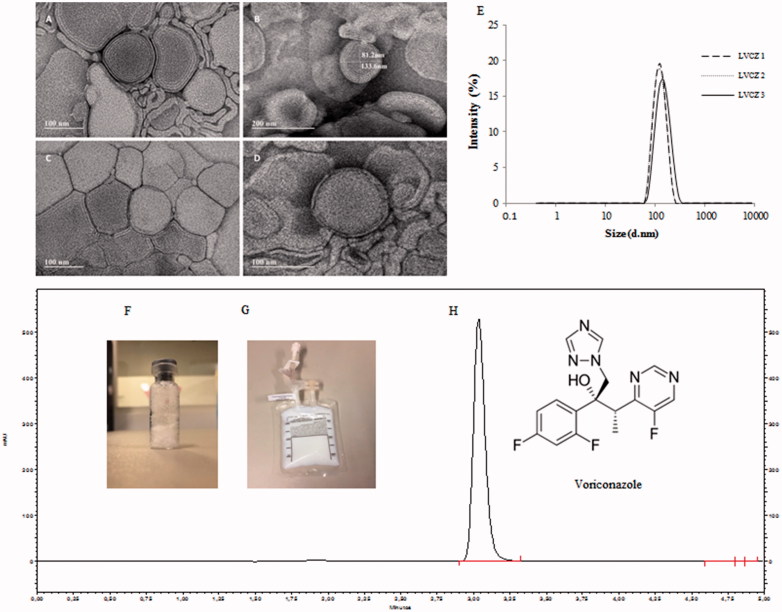
Voriconazole liposomal formulation characteristics. TEM micrograph of empty (blank) liposomes (A,B); VCZ liposomes (LVCZ) (C,D); VCZ liposomes (LVCZ) size distribution profiles by intensity obtained by DLS from three independent batches (E); freeze-dried formulation (F); redispersed freeze-dried LVCZ in a transparent infusion bag (G); and representative chromatogram from VCZ liposomal formulation at 2.0 mg/mL by HPLC with UV–VIS detector (H).